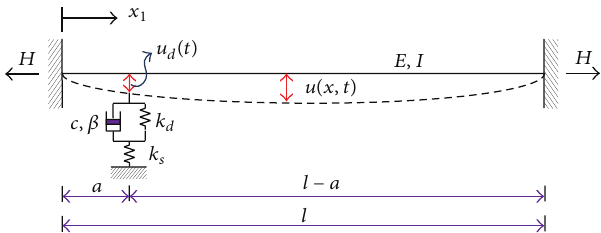
Figure 1: Cable-damper system considering various